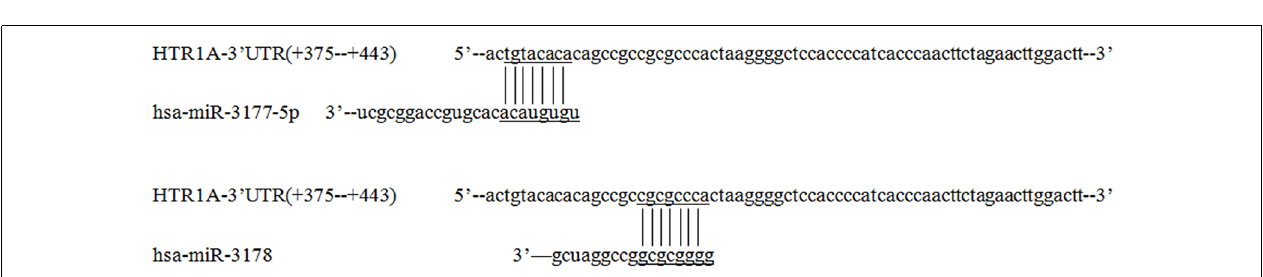
FIGURE 4 | Prediction of miRNAs that recognize the HTR1A gene 3 (cid:48) -UTR region. Based on the number of combined bases and cells expression, TargetScanHuman 7.2 software showed that hsa-miR-3177-5p and hsa-miR-3178 were most likely to regulate expression of the HTR1A gene and the recognition sequences located at +377 bp to +384 bp and +392 bp –+399 bp. The numbers represent the position of the gene (the next base of the stop codon is +1) and the horizontal and vertical lines represent matching